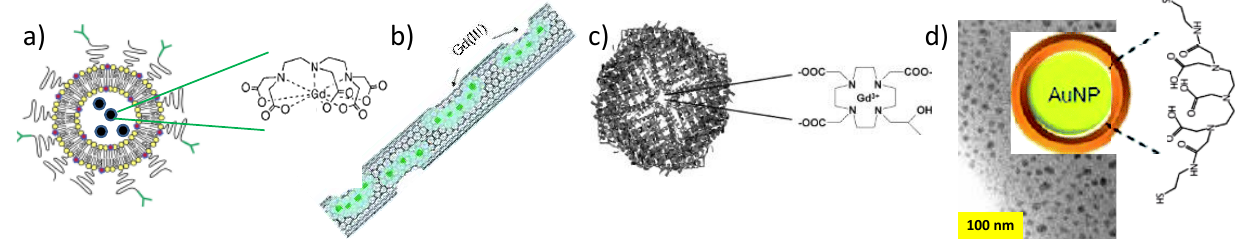
Figure 3. Schematic representation of different monomeric Gd assemblies: (a) Liposomes encapsulating Gd-DTPA complexes, (b) CNTs, and (c) apoferritin compartmentalizing free or coordinated Gd 3+ ions in their cavities, and (d) gold nanoparticles functionalized with Gd-DTPA complexes. Table 1. Longitudinal relaxivities r 1 of different Gd-based CAs